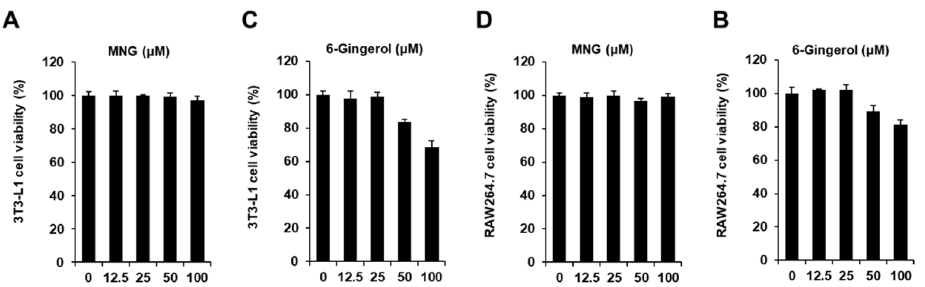
Figure 2. Effect of MNG on the viability of 3T3-L1 preadipocytes and RAW264.7 cells. Effect of ( A ) MNG and ( B ) 6-gingerol (positive control) compared with the control (untreated, 0 µ M) on the viability of 3T3 ‐ L1 preadipocytes for 24 h. Effect of ( C ) MNG and ( D ) 6 ‐ gingerol compared with the control (0 μ M) on the viability of RAW264.7 cells for 24 h. Cell viability was determined using MTT assay ( n = 3 independent experiments, p > 0.05, Kruskal–Wallis nonparametric test). Data represent the mean ± SEM.